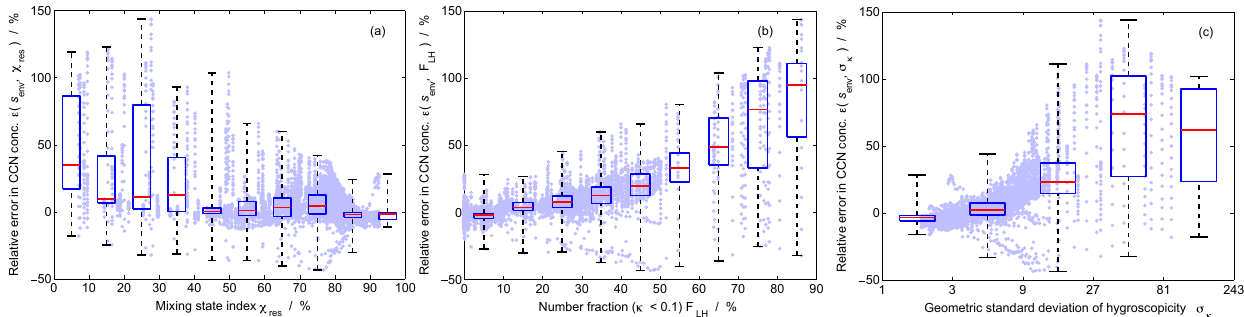
Figure 11. Relative error of (a) (cid:15)(s env ,χ res ) , (b) (cid:15)(s env ,F LH ) , and (c) (cid:15)(s env ,σ κ ) for each individual aerosol population in P (light purple dots), evaluated for 20 supersaturation values between 0.05 and 1%, analogous to Fig.